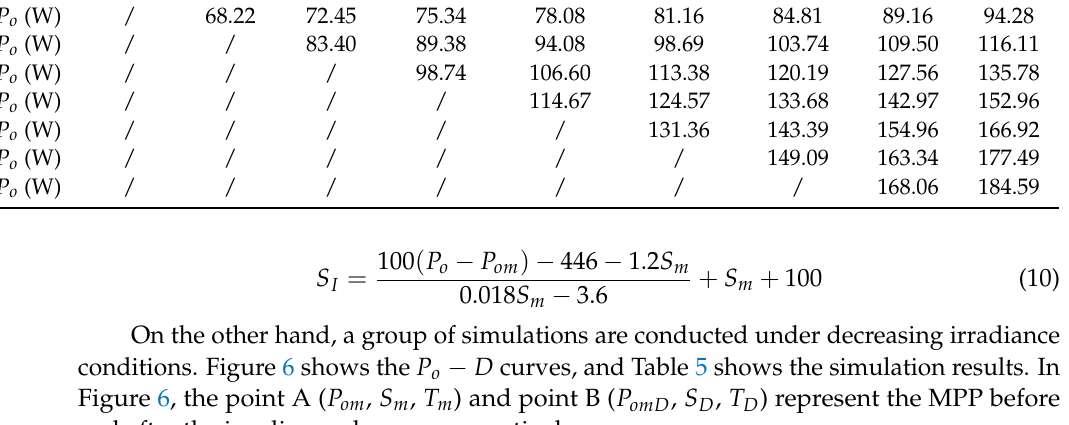
Table 4. Simulation results under increasing irradiance conditions.